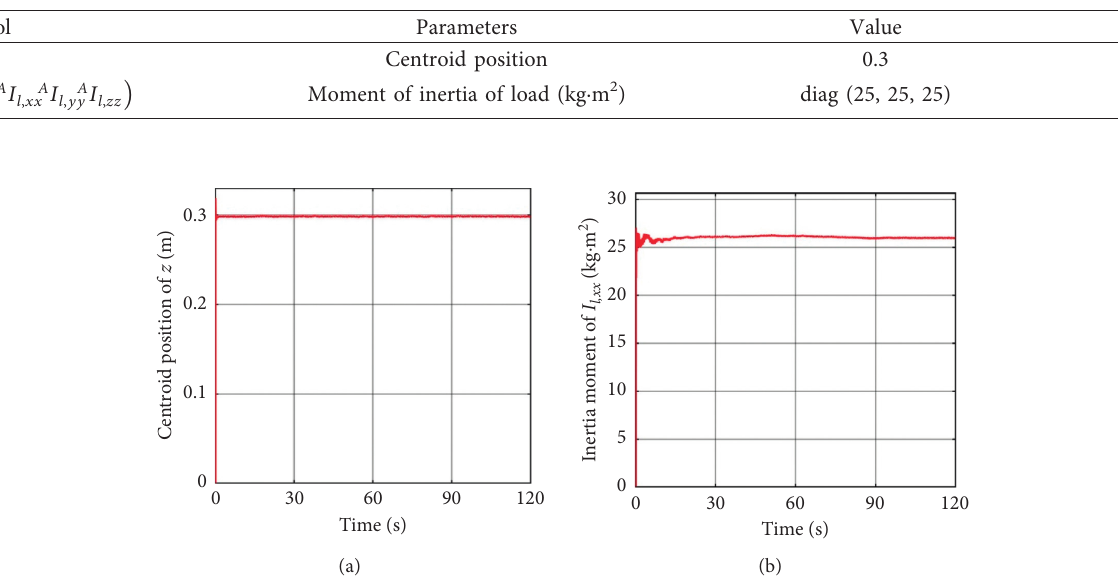
Figure 4: Simulink simulation model of load dynamics parameter identification system. Table 2: Load dynamics parameters to be identified.